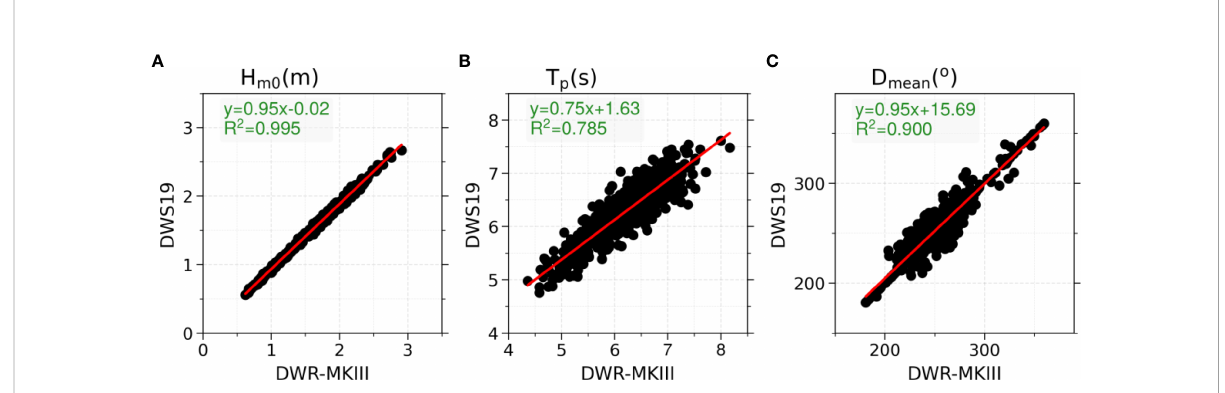
FIGURE 12 Scatter plots of H m0 , T p , D mean observed by DWS19 buoy and